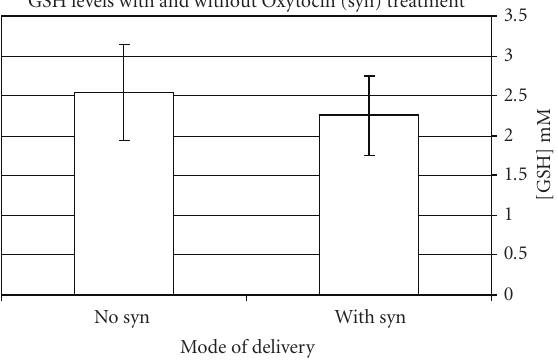
Figure 1: GSH level by Oxytocin treatment.